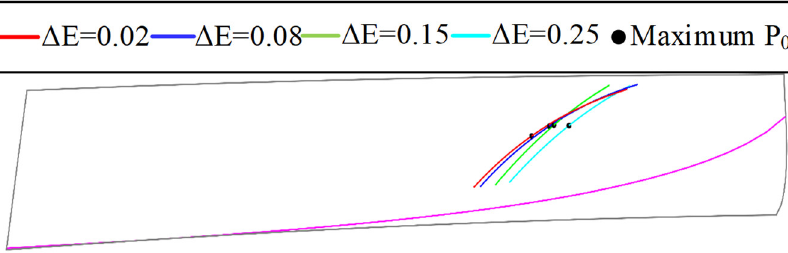
Figure 18. Contact paths of the modified helical face gears with different pinion-offset errors.